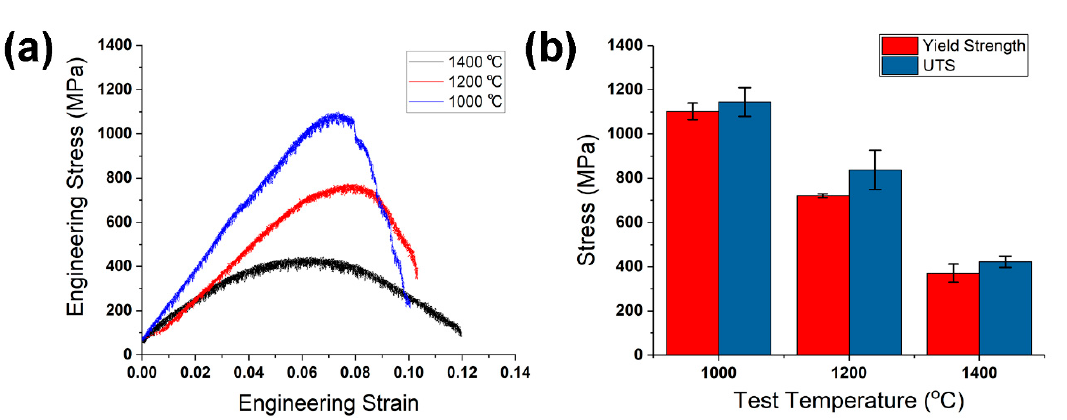
Figure 4. ( a ) High temperature compressive stress-strain plots, and ( b ) yield strength and ultimate tensile strength (UTS) plot of W 0.5 (TaTiVCr) 0.5 alloy at different temperatures.